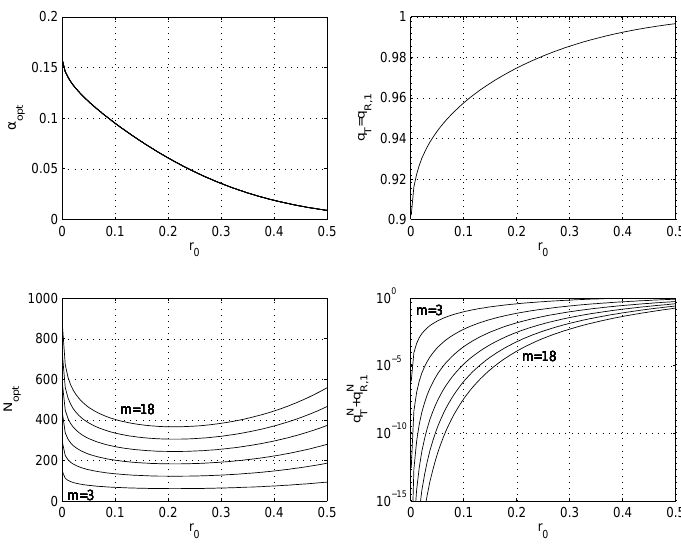
Figure 15. α opt versus r 0 (top left graph), N opt versus r 0 (bottom left graph), q T = q R, 1 versus r 0 (top right graph) and q N and 18